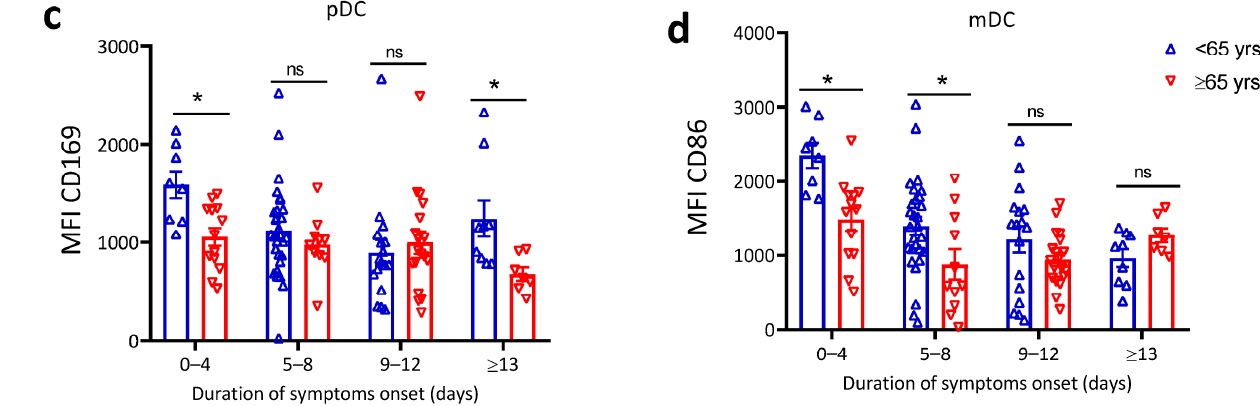
Figure 3. Dendritic cell impairment in patients above 65 years. Analysis of dendritic cell proportion and cell surface activation in PBMC from SARS-CoV-2 patients after indicated duration of symptom onset. ( a ) Percentage of pDC (% CD303 + CD123 + CD11c − DCs). ( b ) Percentage of CD169 expressing pDCs. Mean fluorescence intensity (MFI) of ( c ) CD169 and ( d ) CD86 ( n = 117). The data are shown as mean ± SEM. The statistical comparison of below 65 years (<65 years) vs. above 65 years ( ≥ 65 years) was performed using Student’s t -test (ns: not significant * p < 0.05).